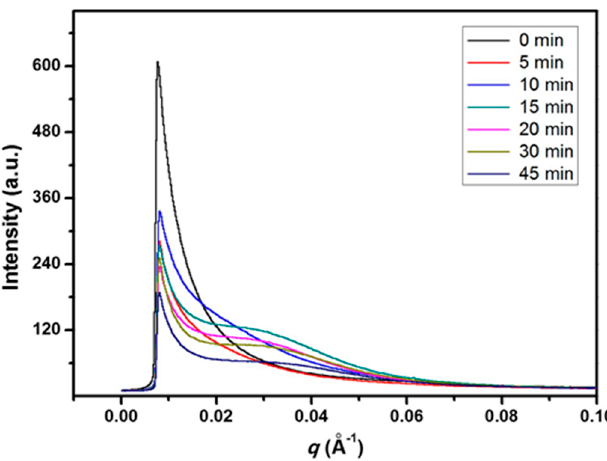
Figure 6. SAXS profiles of blend samples crystallized isothermally at 155 °C for 1 h after annealing at 265 °C for t s .